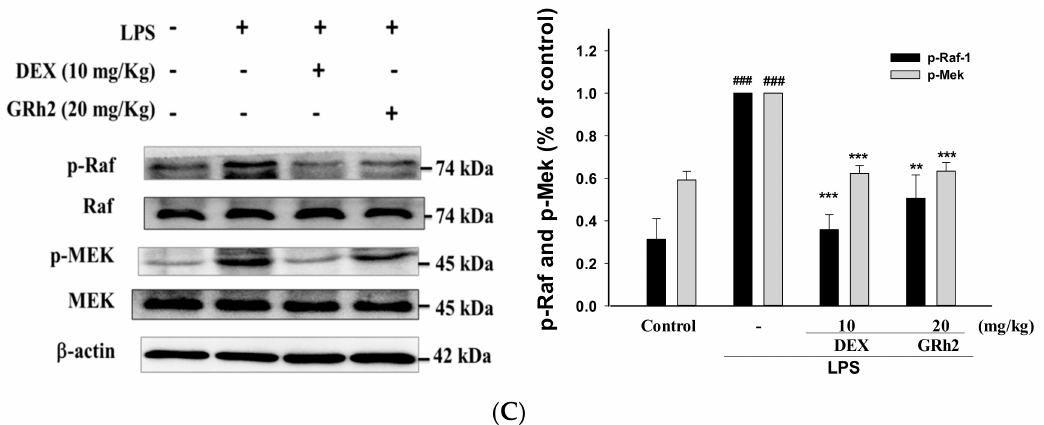
Figure 5. Effects of GRh2 on ( A ) LPS-induced antioxidative enzymes (catalase, superoxide dismutase (SOD), and glutathione peroxidase (GPx)); heme oxygenase-1 (HO-1), Trx-1, NF-E2-related factor 2 (Nrf2)/Keap1 and KAP1; ( B ) TLR4, PI3K, Akt, and mTOR; and ( C ) Raf-1, p-Raf-1, Mek and p-Mek protein expression in the lungs. Protein levels of catalase, SOD, GPx, HO-1, Trx-1, Nrf2/Keap1, KAP1, TLR4, PI3K, Akt, mTOR, Raf-1, p-Raf-1, Mek and p-Mek protein expression in lung homogenates were evaluated by western blot analysis after LPS challenge 6 h hours later. Densitometric analysis of the relevant bands was performed. Data are represented as mean ± S.E.M. ( n = 2). ## p < 0.05 and ### p < 0.001 compared with sample of control group. ** p < 0.01 and *** p < 0.001 compared with LPS-only